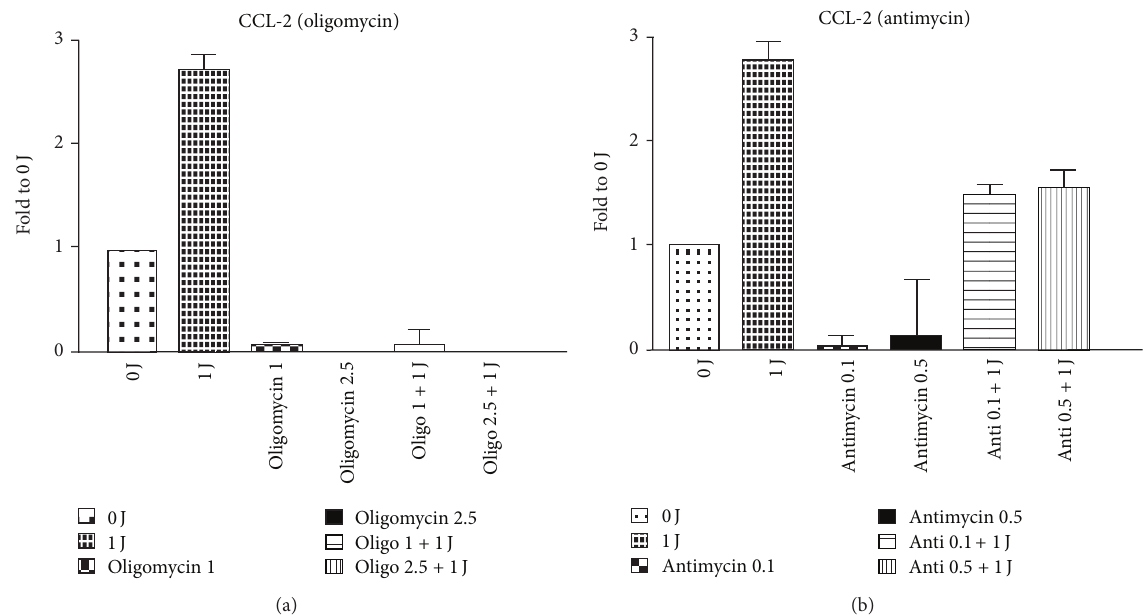
Figure 4: Real-time PCR results showed that 1J/cm 2 of 660 nm LLLT-induced CCL2 mRNA expression was inhibited by oligomycin (a) and antimycin (b). ∗ 𝑃 < 0.05 between LPS and LPS plus LLLT